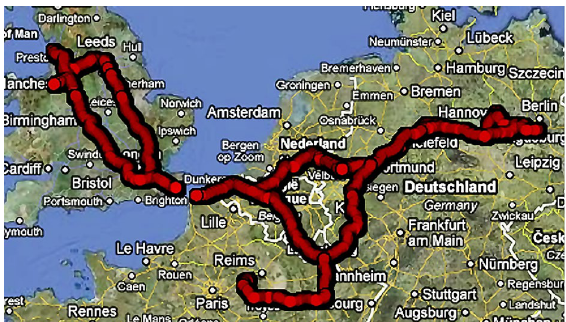
Fig. 4. Example of GPS semitrailer